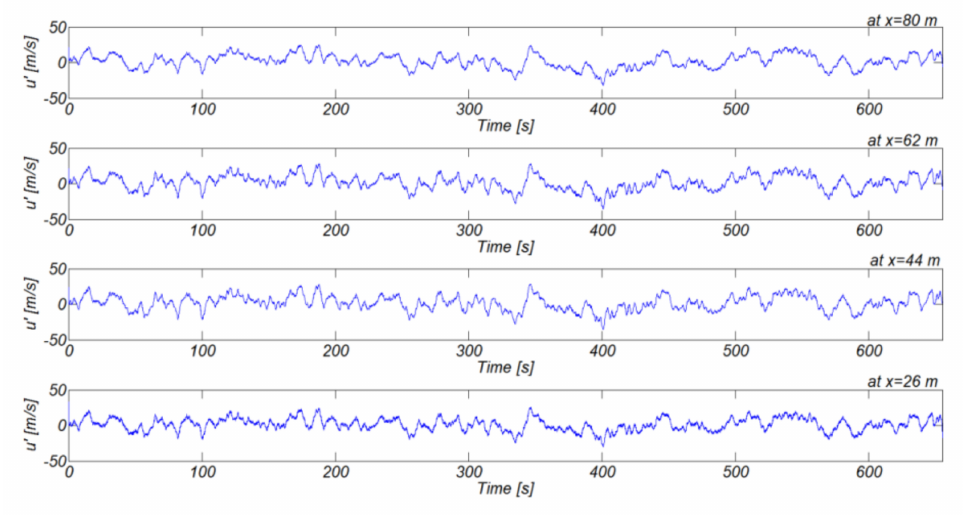
Figure 13. Time series for numerically simulated turbulent wind velocities at x = 80, 62, 44, and 26 m [rough